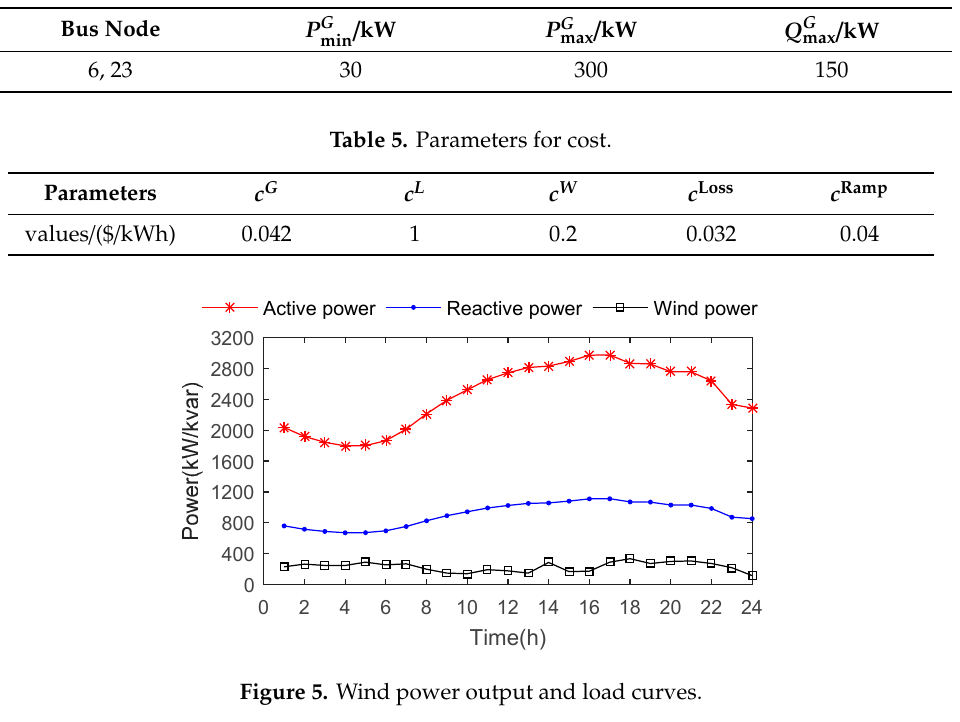
Table 4. Parameters of gas-fired units.